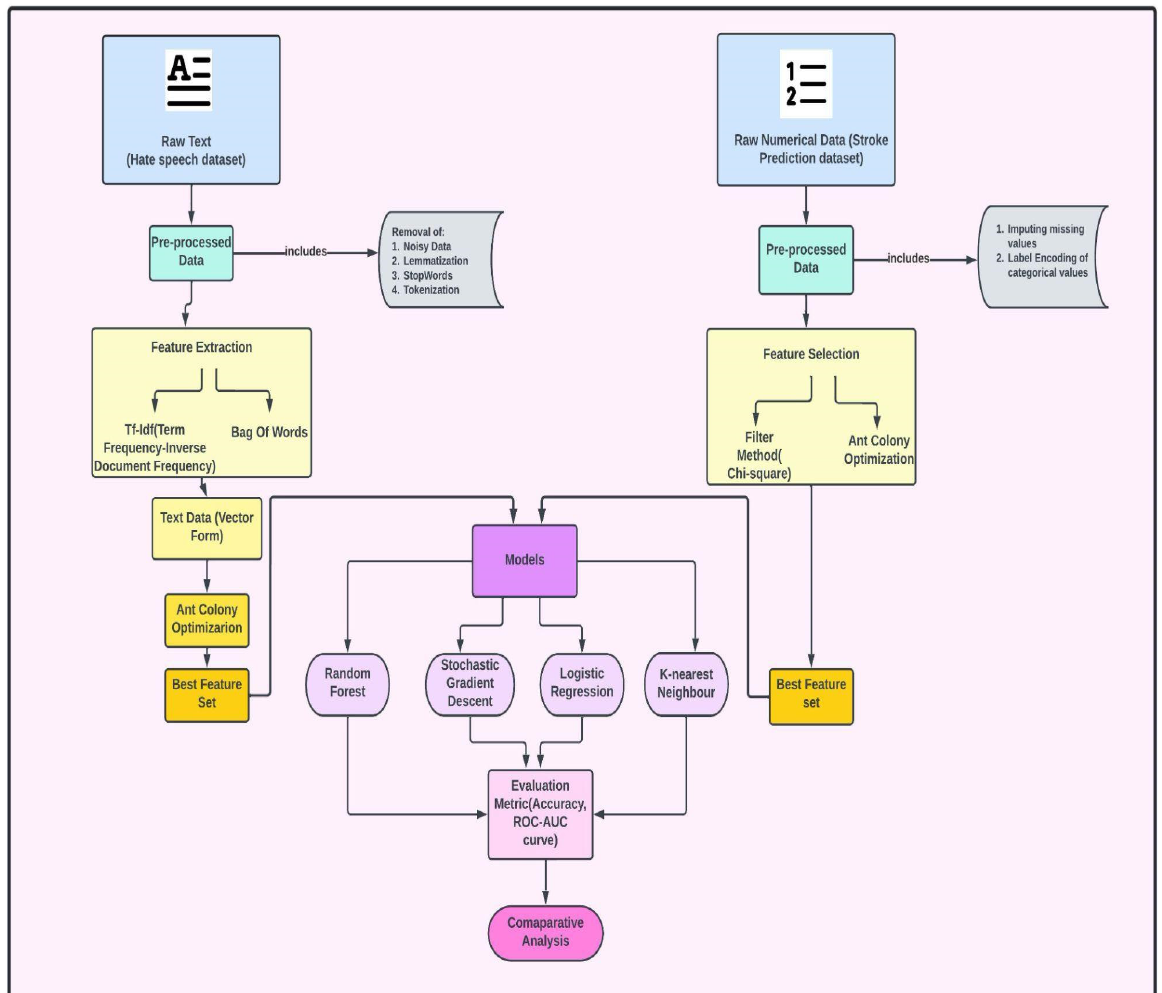
Figure 10. Proposed architecture with Ant Colony Optimization (ACO) applied on different machine learning algorithms.